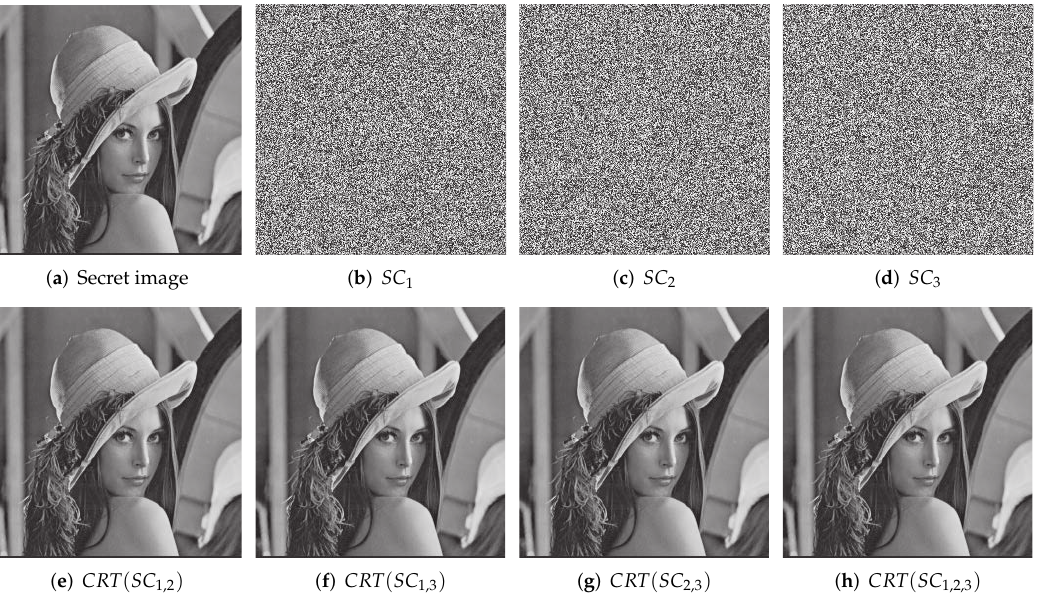
Figure 2. Experimental results of the introduced scheme for the ( 2,3 ) threshold. ( a ) Secret image; ( b – d ) three generated shares SC 1 , SC 2 and SC 3 ; ( e – g ) recovered images with two shares; ( h ) recovered image with three shares.